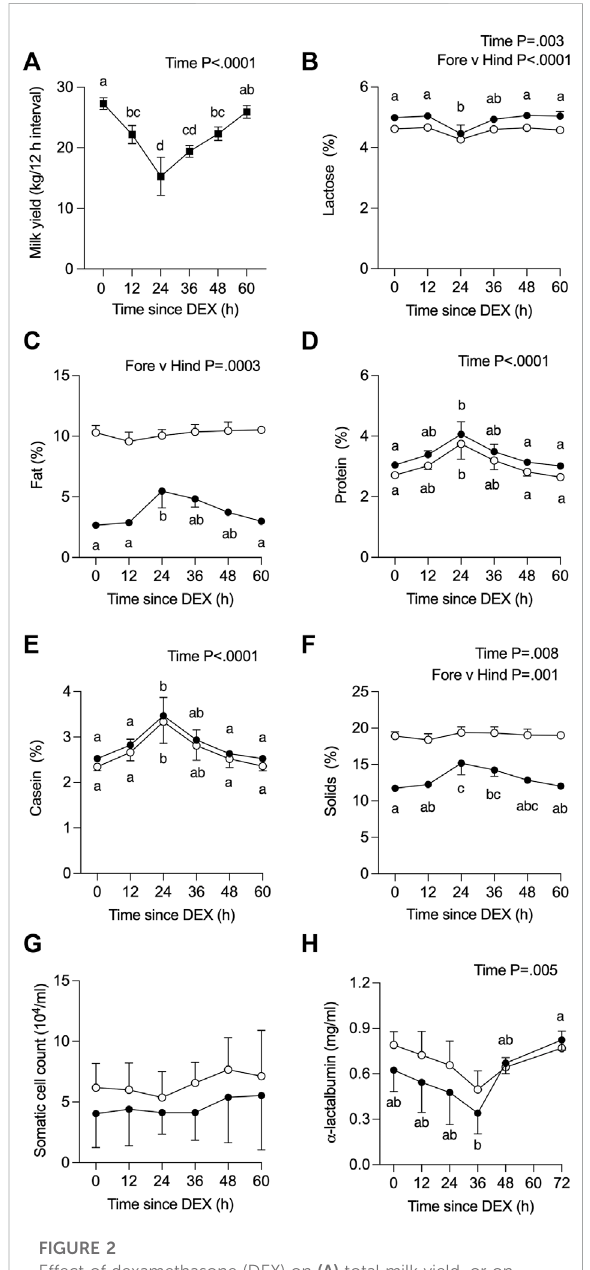
FIGURE 2 Effect of dexamethasone (DEX) on (A) total milk yield, or on components (%) in foremilk (black circles) and hindmilk (open circles) for (B) lactose, (C) fat, (D) protein, (E) casein, and (F) total solids,aswellas (G) somaticcellcount,and (H) α -lactalbumin (LALBA) concentration. Data are means ± SEM ( n = 3 cows). Time zero represents an average of − 36, − 24, − 12, and 0 h (h) relative to DEX for all components except for LALBA, where the baseline value is the average of − 24, − 12, and 0 h a, b, c, d Means with different superscripts are different ( p < 0.05). The p -value for a main effect of time or milk type is indicated on each panel when p <